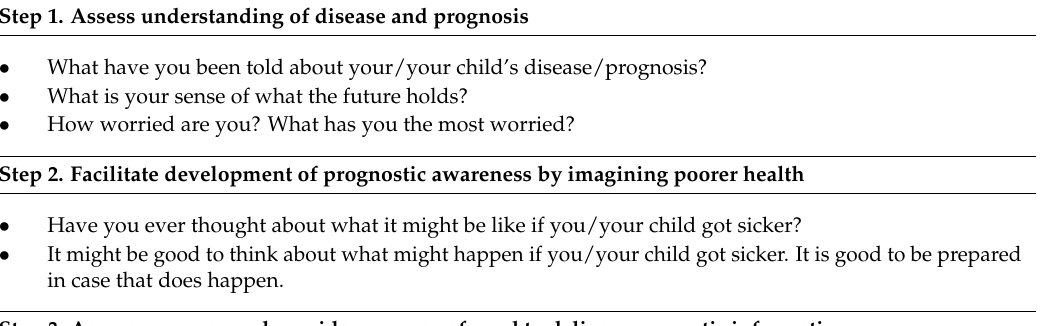
Table 3. Cultivating prognostic awareness over